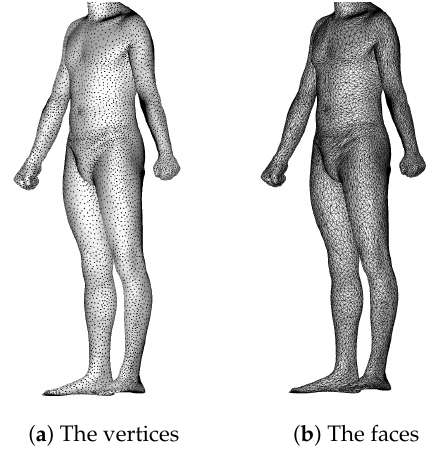
Figure 1. The mesh of the individual S0013